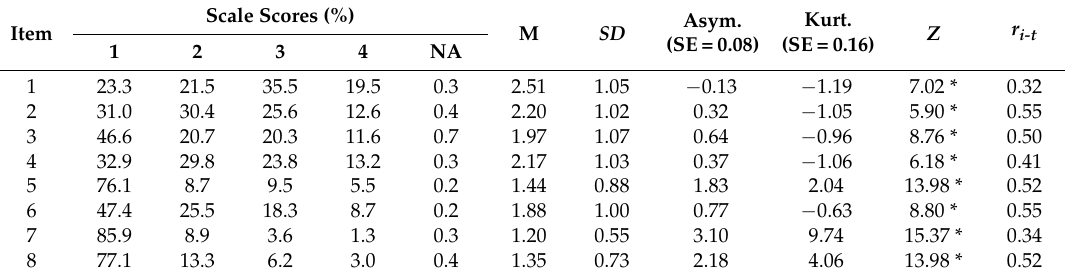
Table 1. Descriptive statistics for the application of the High-Risk Internet Behaviours Questionnaire to the sample ( N =